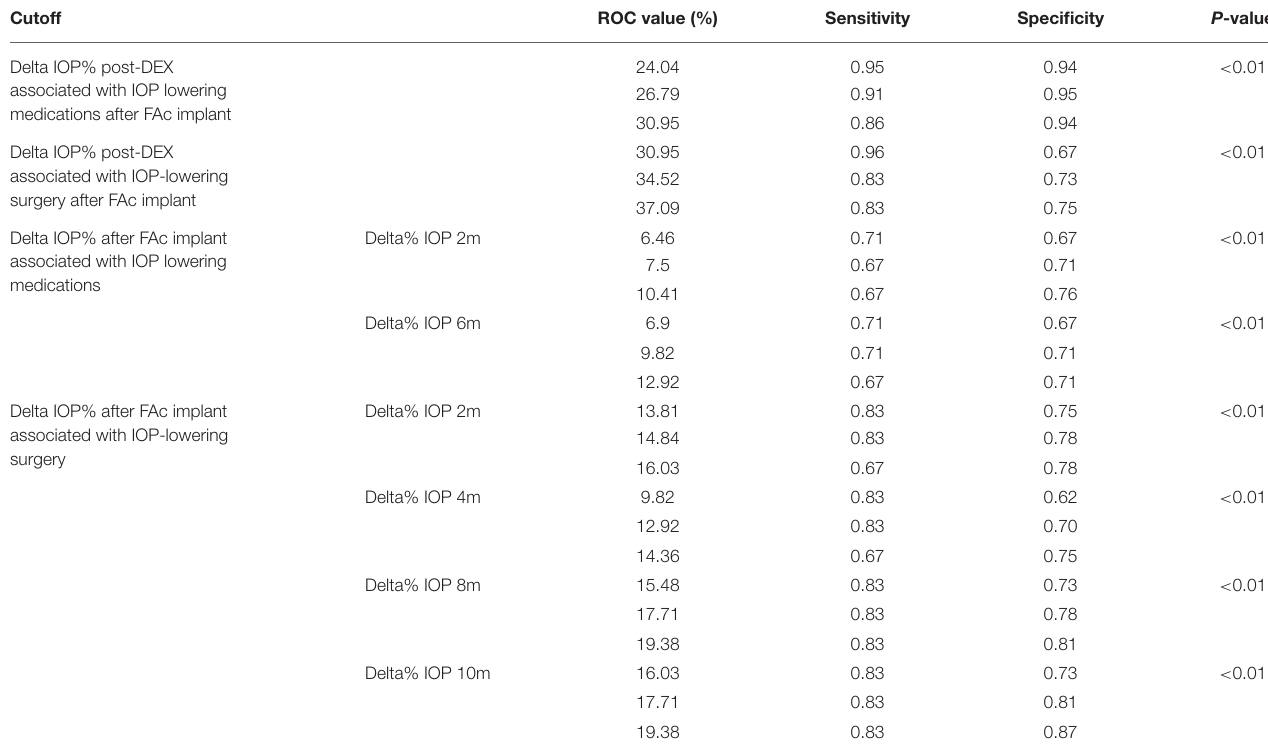
TABLE 5 | ROC analysis detecting statistically significant IOP cutoffs associated with the need of IOP-lowering medications or IOP-lowering surgery after FAc implant. Cutoff ROC value (%) Sensitivity Specificity P